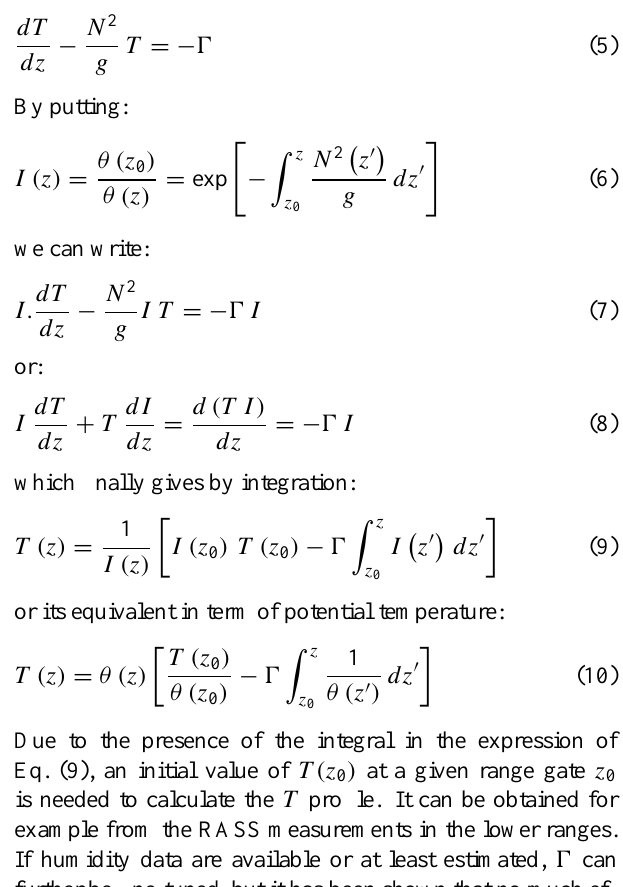
Fig. 3. Horizontal noise pollution with acoustic transmitters at CNRM/Toulouse installed in the centre of the 45MHz radar an- tenna (grid) near the M´et´eo-France buildings (white lines). (a) Sin- gle transmitter, (b) 4 transmitters located respectively at the coor- dinates (0,0), (1.4,1.13), (0.4, 1.75), and (1.8,3.12) relatively to the antenna grid